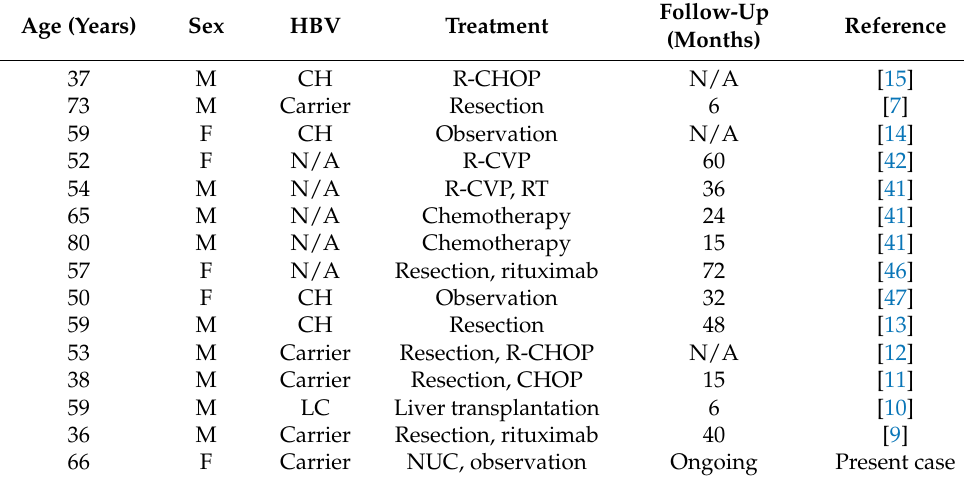
Table 4. Reported cases of primary hepatic extranodal marginal zone lymphoma of MALT lymphoma with